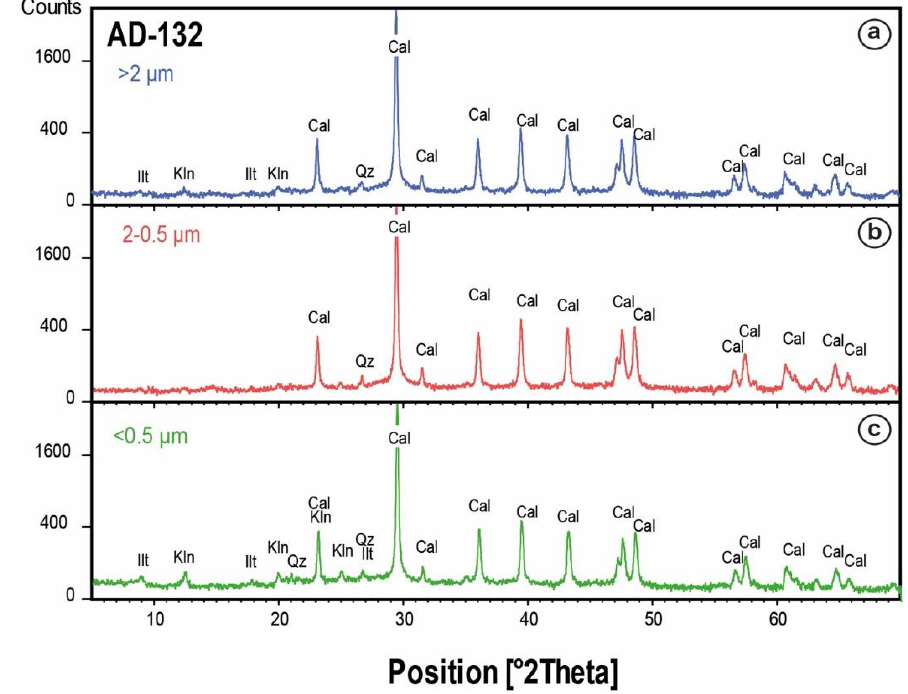
Figure 9. XRD patterns of extracted binder fractions of Layer L2 of Sample AD-132: ( a ) XRD pattern of >2 µm fraction, ( b ) XRD pattern of 0.5–2 µm corresponding to the datable fraction and ( c ) XRD pattern of <0.5 µm fraction.